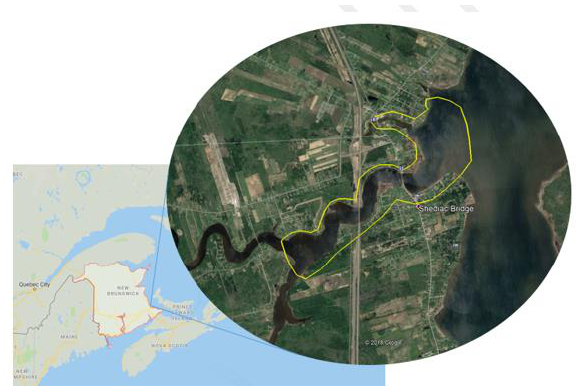
Figure 1. Location of the eelgrass sites in Shediac Bay, New Brunswick, Canada